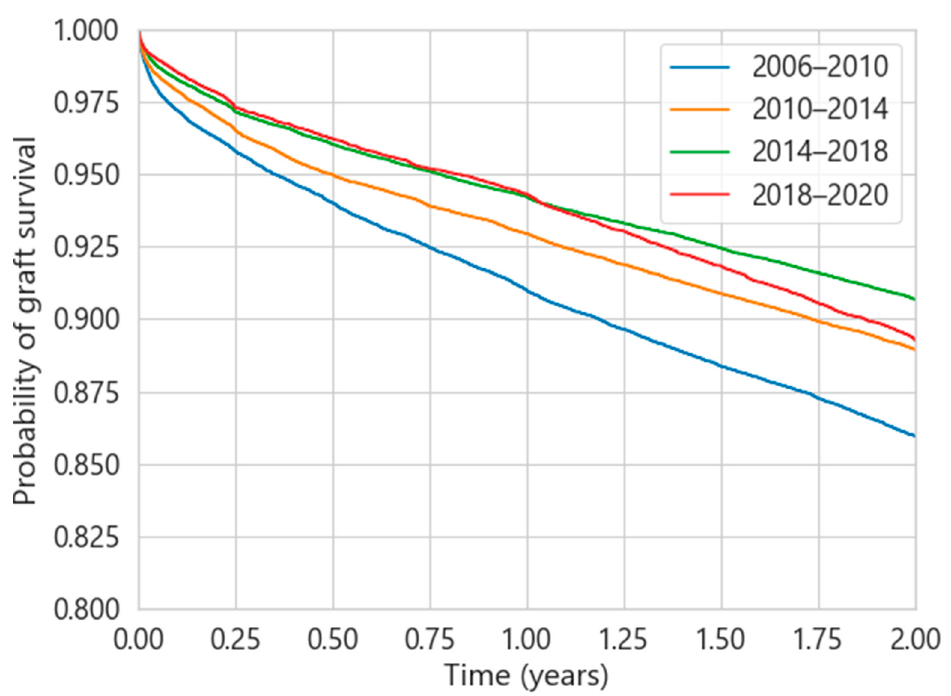
Figure 2. Probability of graft survival in the first two years for UNOS at different time intervals.